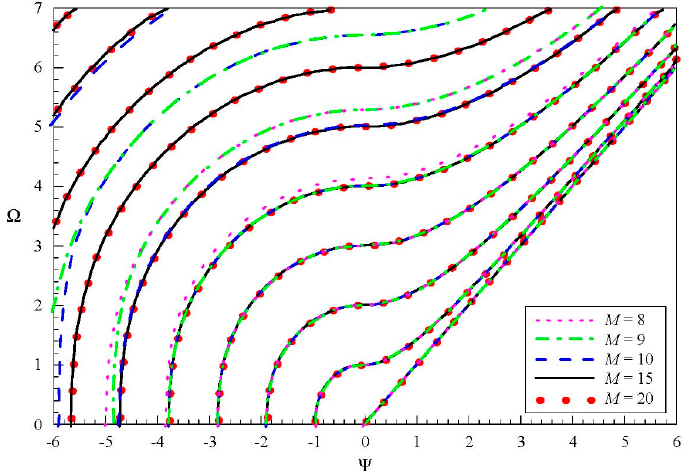
Figure 4. Dispersion curves of the SH wave in a piezoelectric plate for various “ M ”.